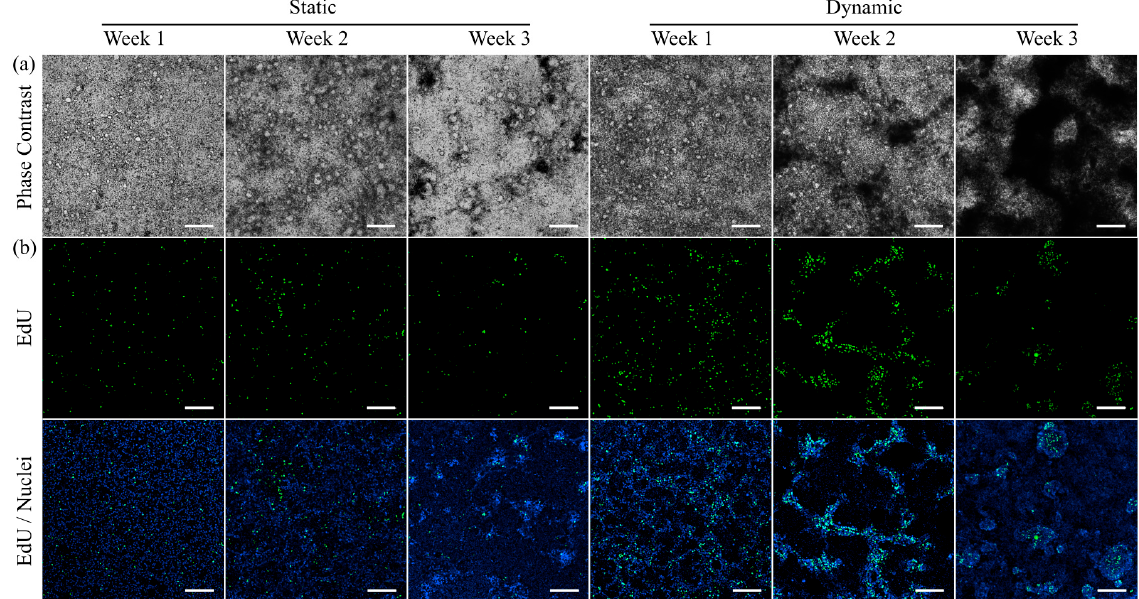
Figure 2. Morphology and proliferation of HT29-MTX cells under static and dynamic culture conditions at various time points. ( a ) Morphology was assessed via phase contrast microscopy and ( b ) newly synthesized DNA was visualized with EdU-Alexa ® 488 (green) and imaged using confocal microscopy. Nuclei were counterstained with Hoechst 33342 (blue). ( a , b ) show independent samples. (Scale bars: 200 µm).